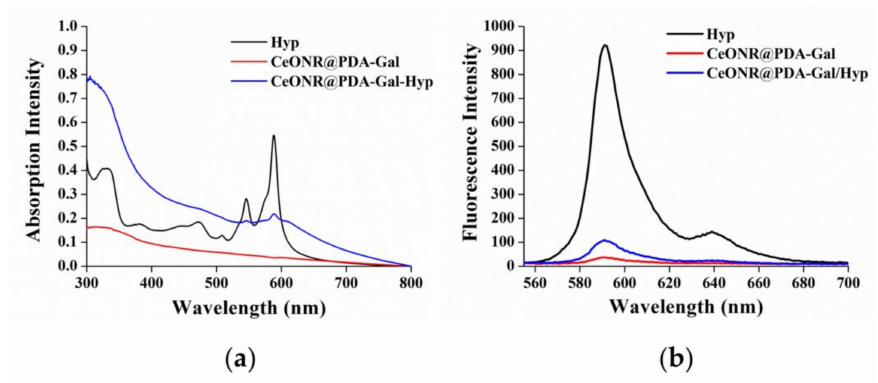
Figure 2. ( a ) UV-Vis spectra and ( b ) fluorescence spectra of Hyp, CeONR@PDA-Gal, and